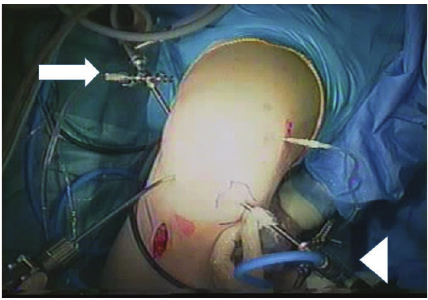
Figure1:Atwo-camerasystemforPCLreconstruction.Onecamera (arrowhead) is used for the anterior approach and the other (arrow) is used for the posteromedial approach.